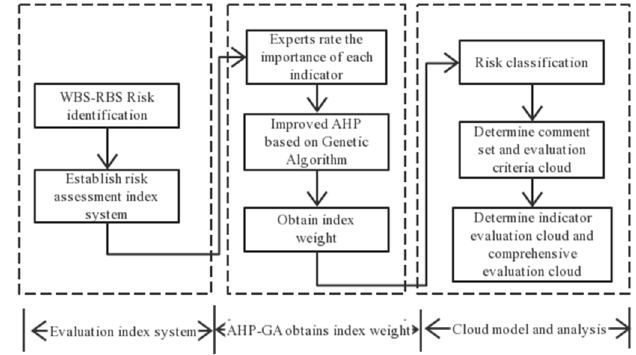
Figure 1. Flow chart of risk assessment for immersed tube tunnel